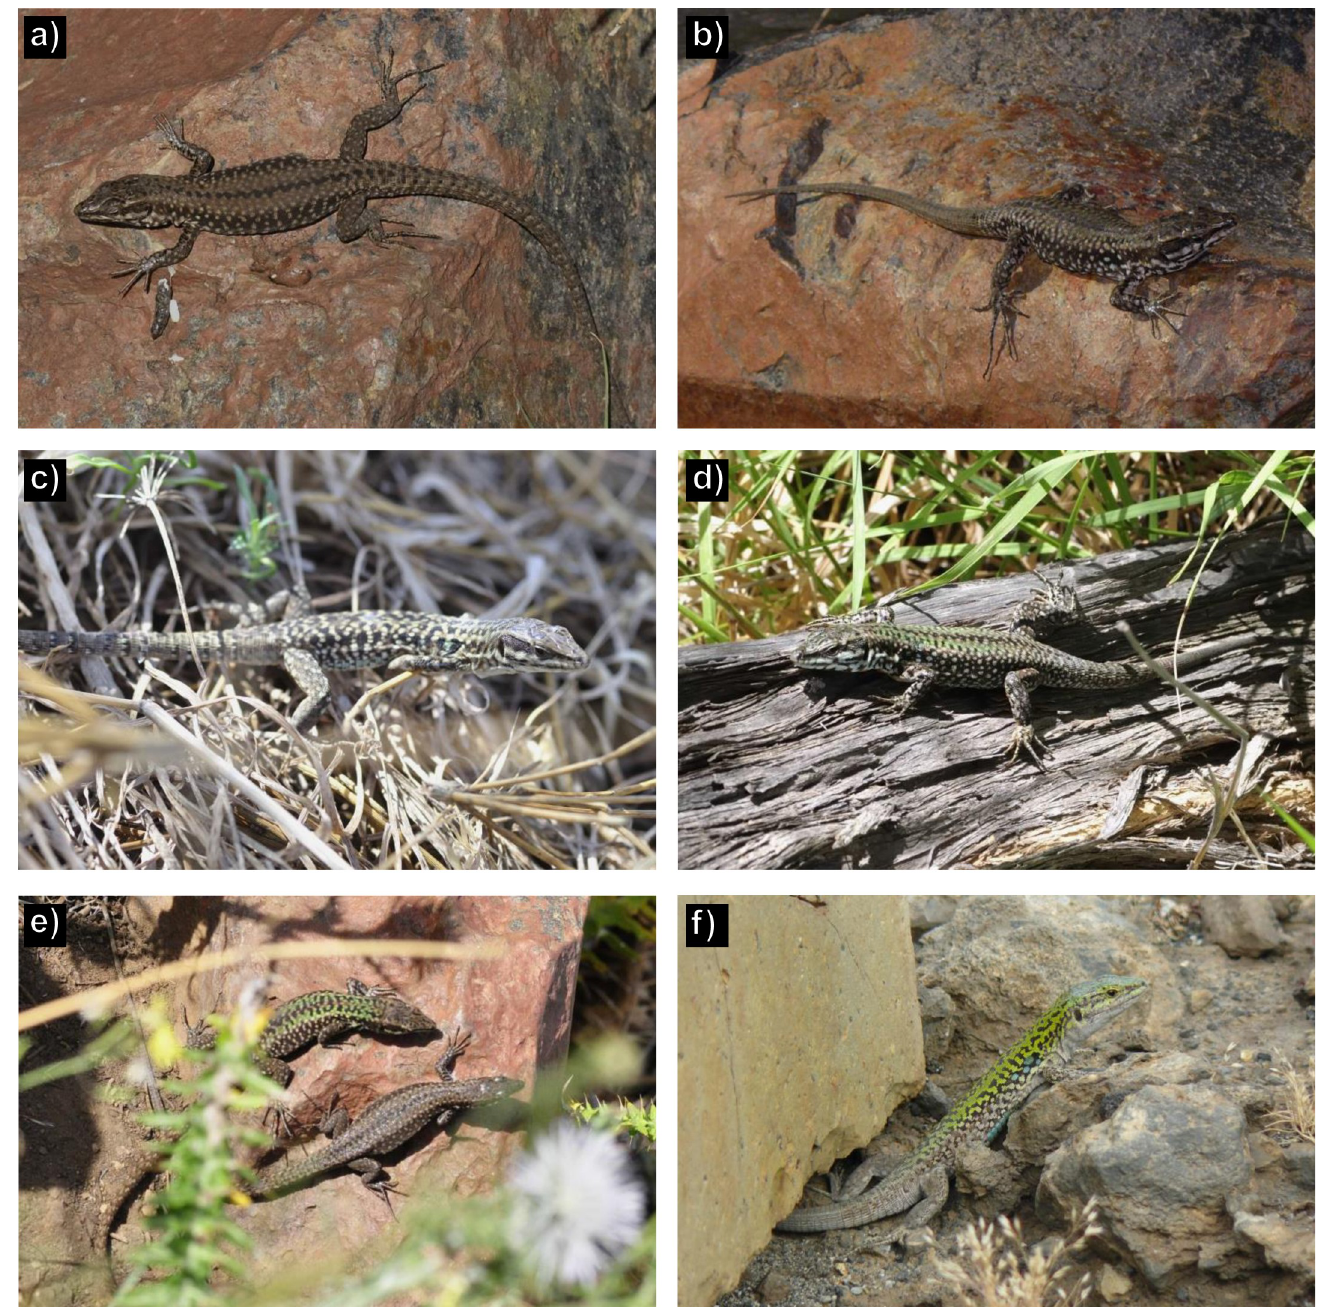
Fig 3. a, b): typical phenotype of Podarcis raffonei from Capo Grosso c, d): individuals with the green phenotype, showing the typical spotted throat but a green dorsal pattern similar to the phenotype of P . siculus . e): interactions between a male with a green phenotype and a female with typical P . raffonei phenotype; a few seconds later the female performed tongue flicking. f) typical phenotype of P . siculus on Vulcano (photos by G.F. Ficetola and D.